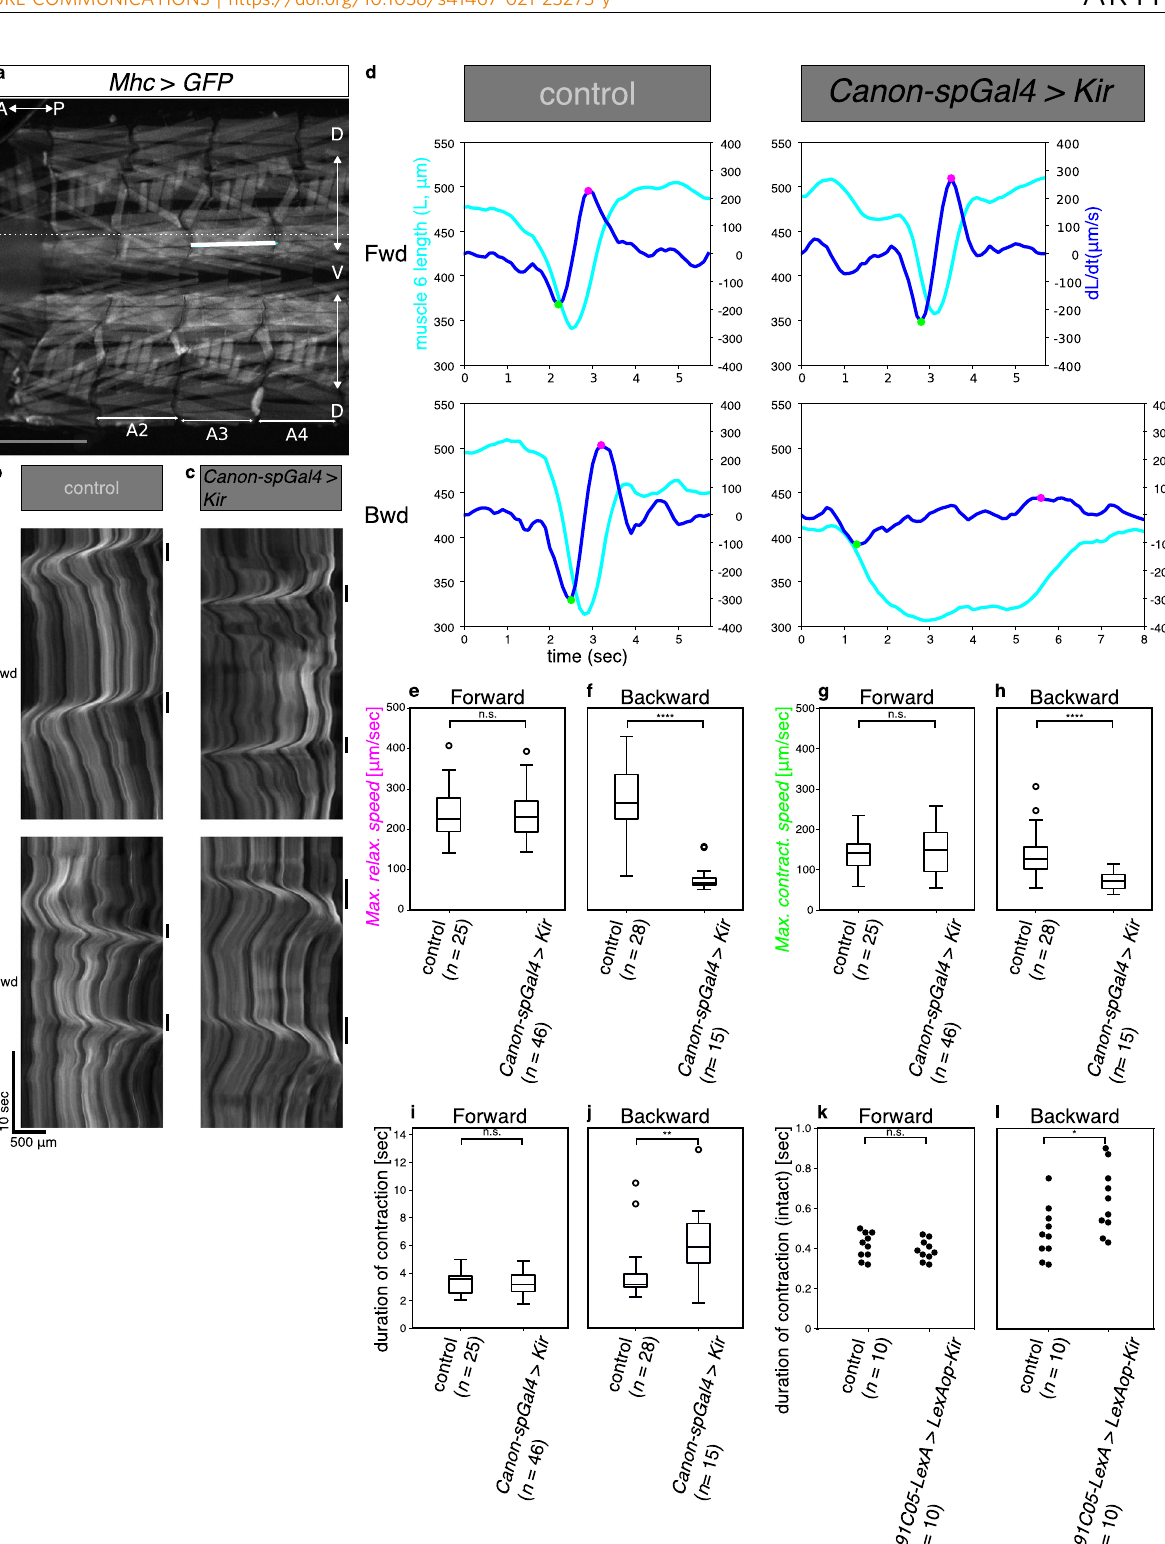
of-function experiments. We used Canon-spGal4 to express Kir2.1 (inwardly-rectifying potassium channel) 35 in Canon and Wave neurons to suppress baseline excitability, and observed muscle dynamics in dissected larvae undergoing spontaneous forward and backward peristalses (Fig. 3a). We found that the muscular relaxation was disrupted and peristalses duration were prolonged during backward peristalses, but not forward